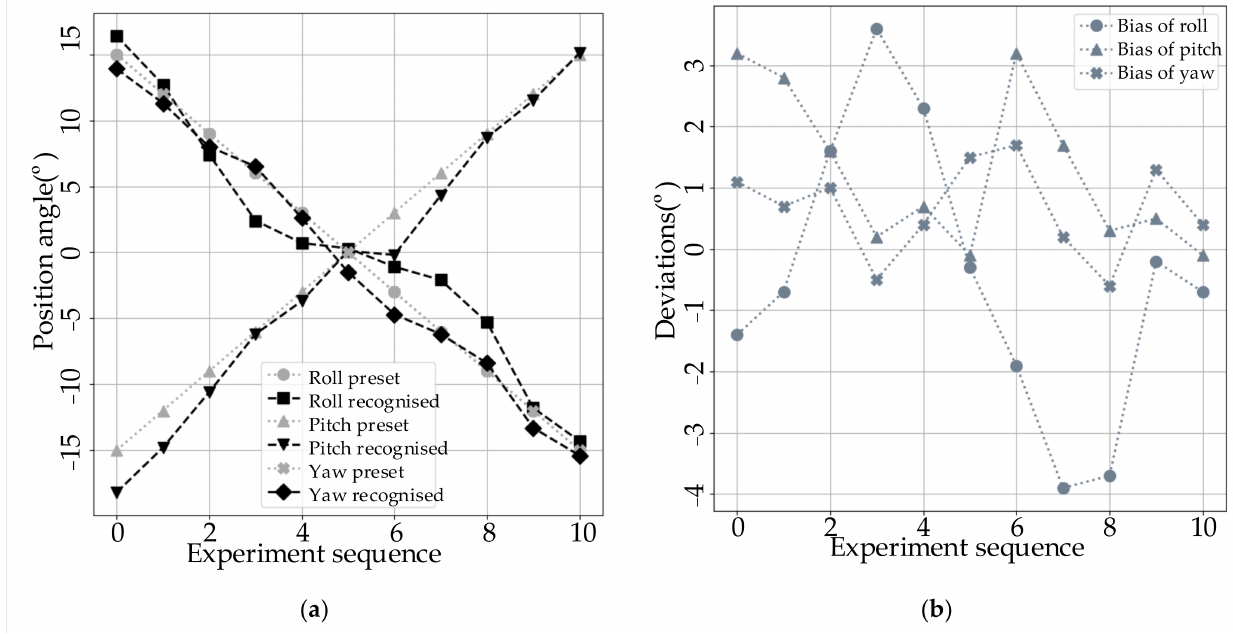
Figure 12. Result of experiment 2: ( a ) experimental result, ( b ) error distribution. From the comparison between the set value and the detected value of the 3-DoF position angle in Figures 11 and 12 and Tables 1 and 2, it can be seen that the proposed sensorless detection method has a good on-line detection effect; the maximum